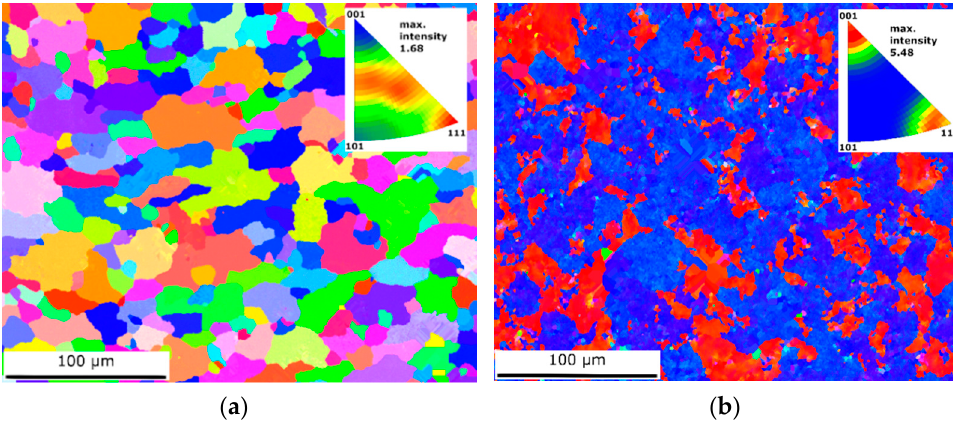
Figure 2. Orientation maps of ( a ) CG and ( b ) HE samples.